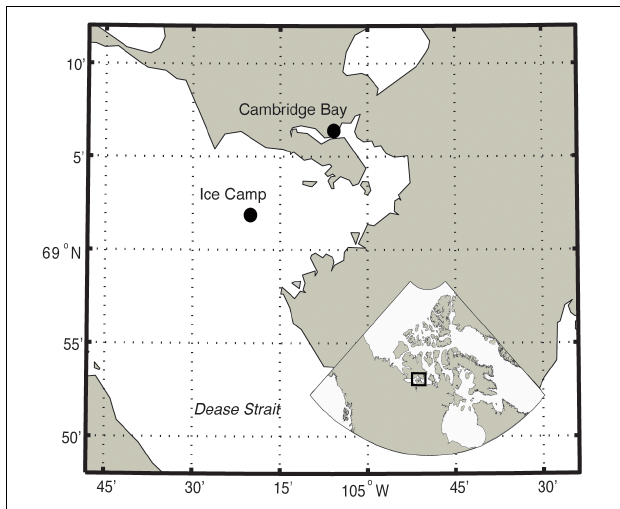
FIGURE 1 | Location of ice camp-based sampling location (69.03 ◦ N, 105.33 ◦ W) in Dease Strait, Nunavut,